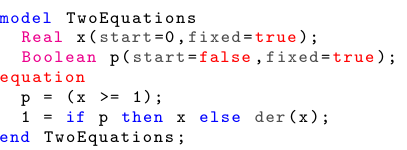
Figure 1. Modelica model of a simple two-equation